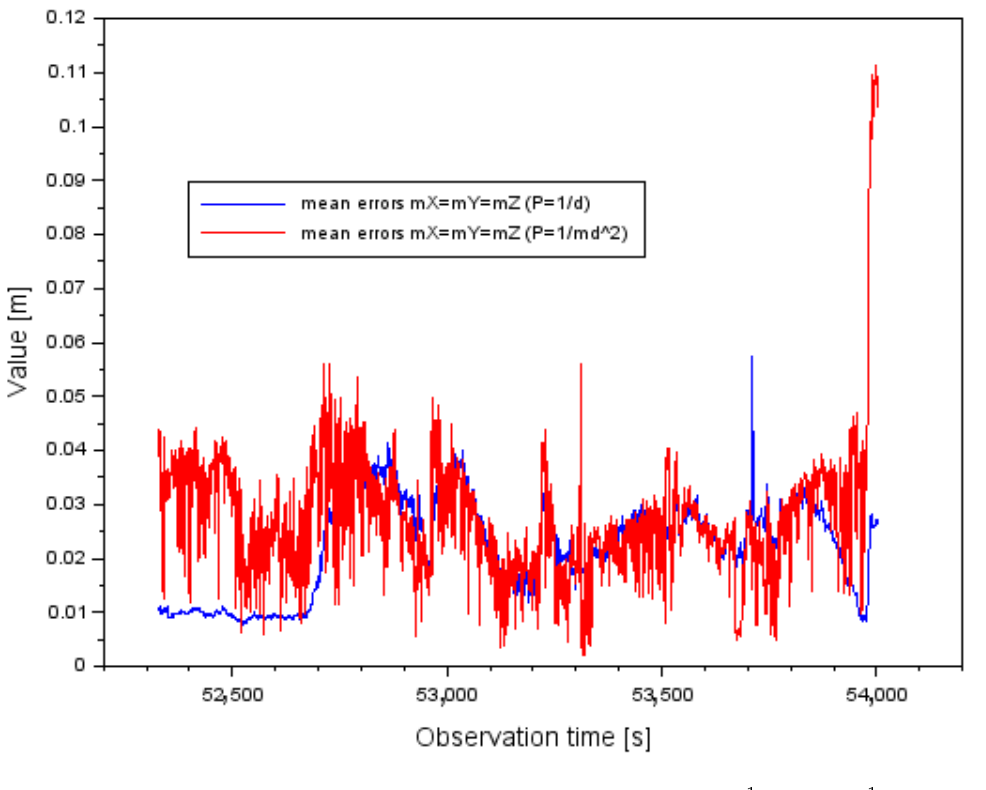
Figure 10. The mean errors for measurement weights P = 1